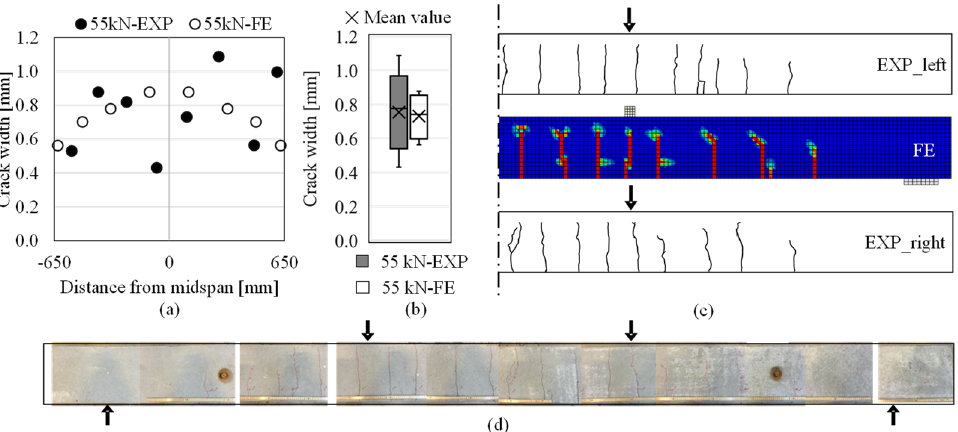
Figure 20. Comparison of cracks formed in the reference RC beam at the load of 55 kN regarding ( a ) crack pattern; ( b ) crack widths in the constant moment region (EXP: experimental results, FE: numerical results); ( c ) crack widths compared in box-and-whisker plots and ( d ) assembled photos depicting the crack pattern after the flexural test.